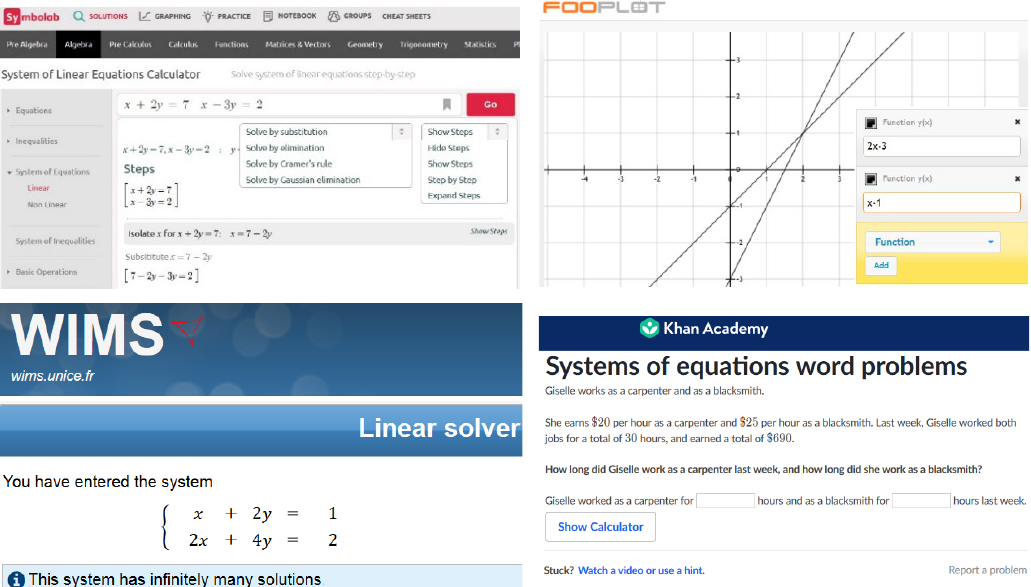
Figure 1. Main math digital tools used during the